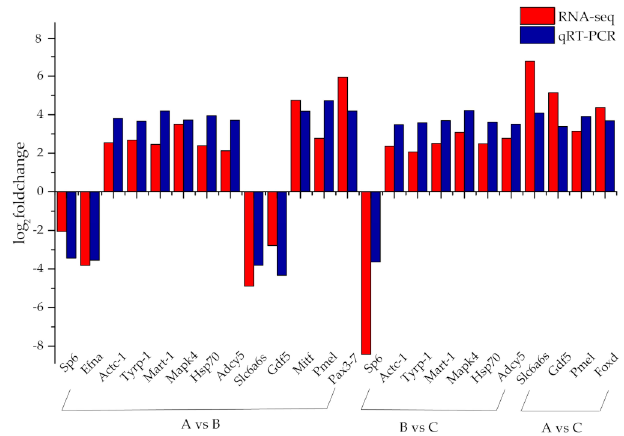
Figure 4. Comparison of gene expression data between RNA-seq and quantitative real-time poly- merase chain reaction (PCR) (qRT-PCR). The x-axis presents the gene name, and the y-axis presents a fold change in gene